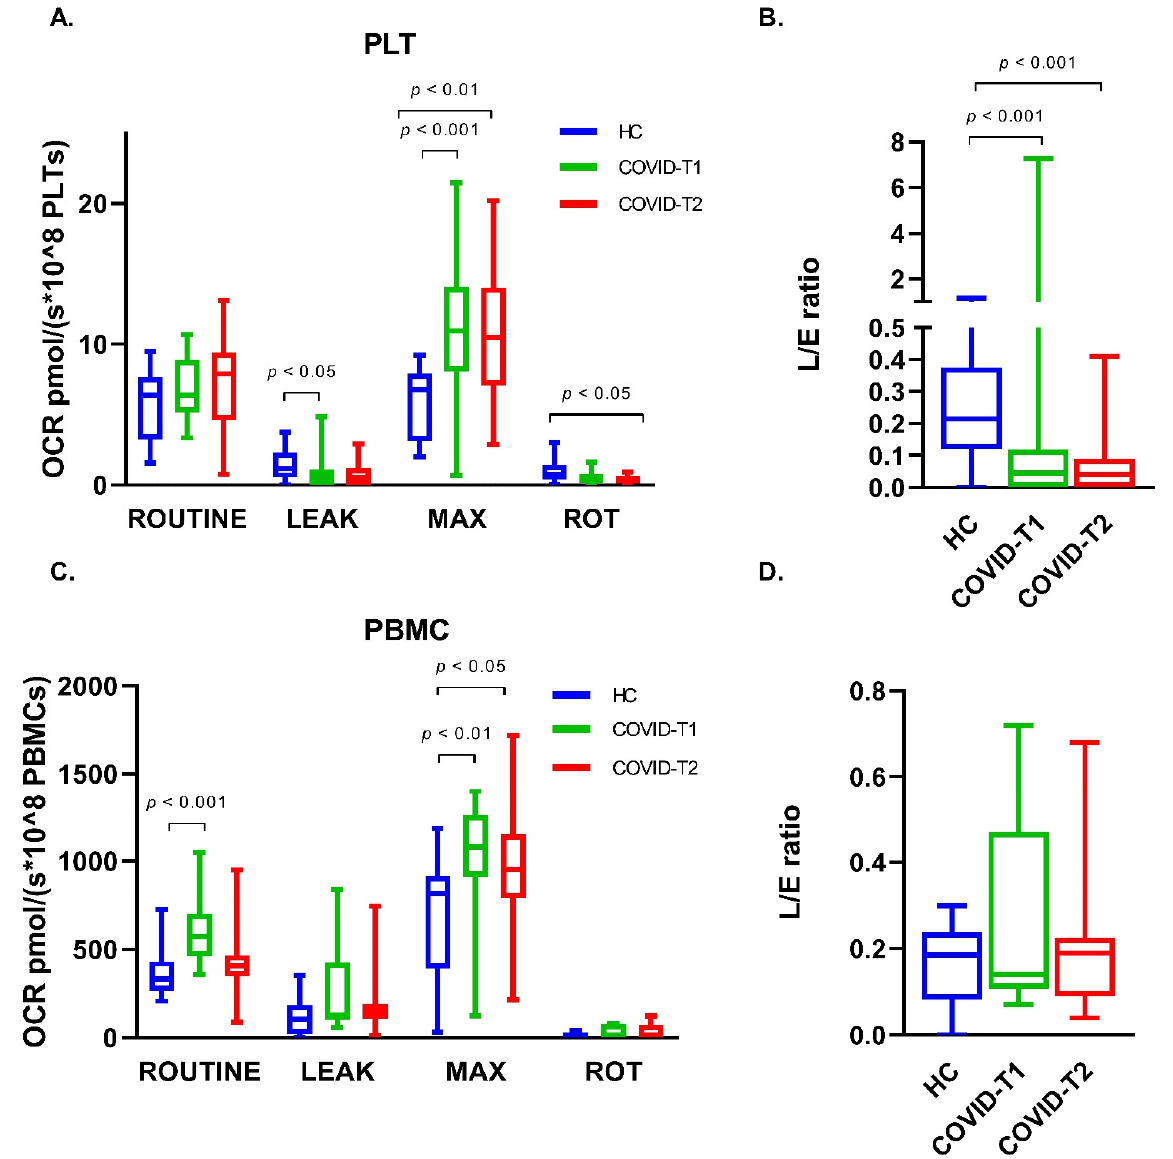
Figure 5. Oxygen consumption rate (OCR) for ROUTINE, LEAK, maximal respiration (MAX), and respiration after inhibition of complex I by rotenone (ROT) in ( A ) platelets and ( C ) PBMC. LEAK/ET coupling control ratio (L/E Ratio) in ( B ) platelets and ( D ) PBMC for the healthy control (HC), COVID-T1, and COVID-T2 groups. Values displayed as median ± min/max values.